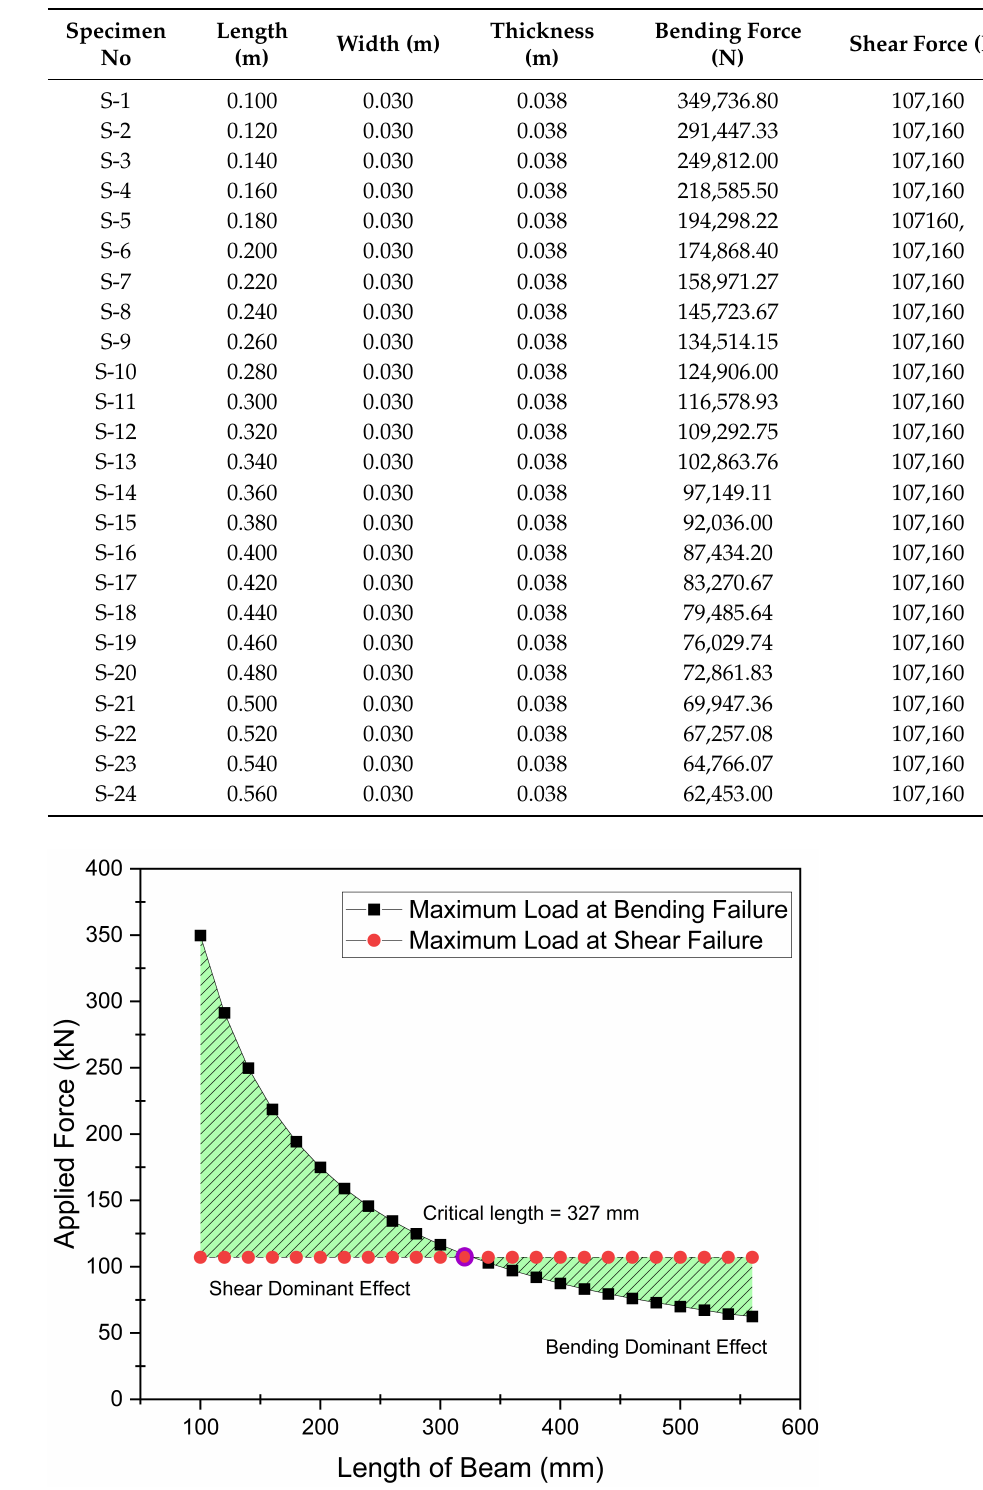
Table 6. Analytical evaluation of bending and shear forces for varying lengths of the specimens to determine the critical length.